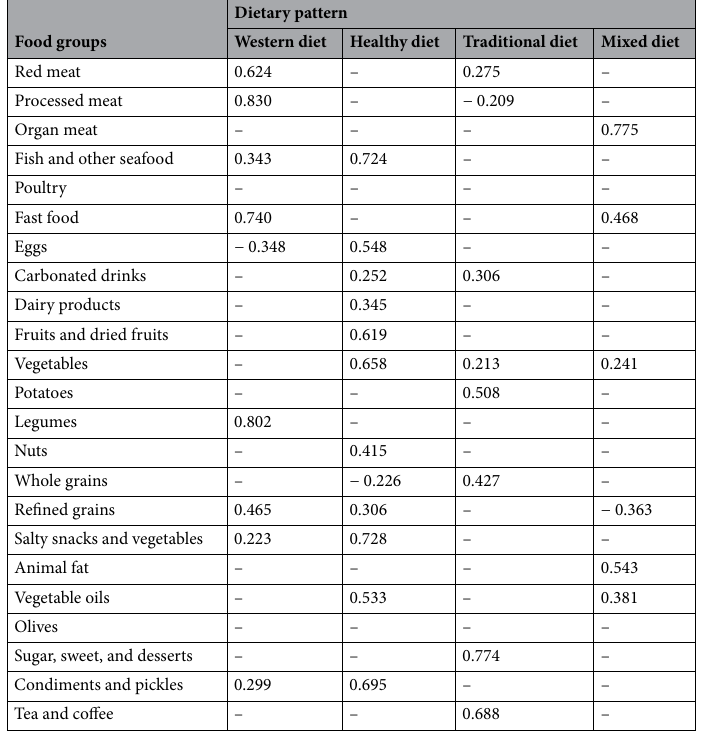
Table 2. The factor loading matrix for five major dietary patterns identified by the principal component approach (PCA). Factor loadings <|0.20| were